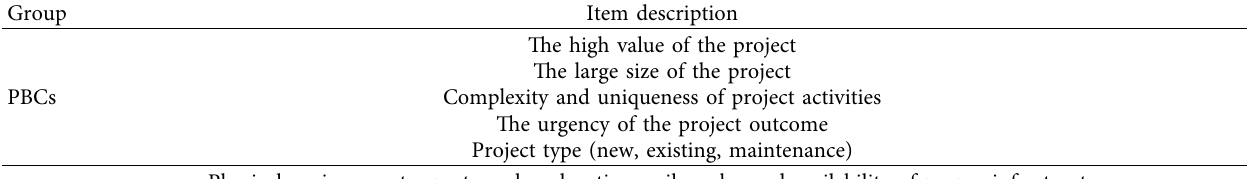
Table 12: Moderator groups affecting relationship between delay and success factors.